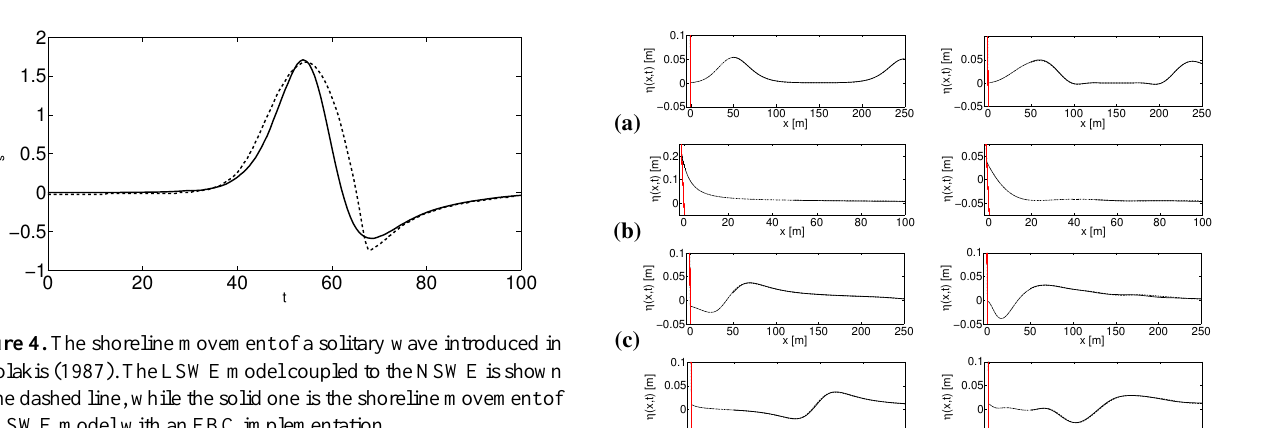
Fig. 5. A solitary wave initial condition for the NSWE (dotted- dashed line) coupled to the linear model (dashed line), and the linear model with the EBC implementation (solid line) at x = 50 m . The solid and dashed lines are on top of another.